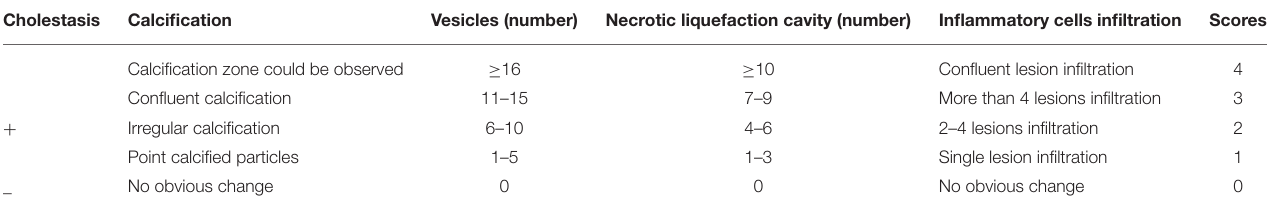
TABLE 2 | Pathological scores of liver lesions’ inflammatory changes in patients with hepatic AE. Cholestasis